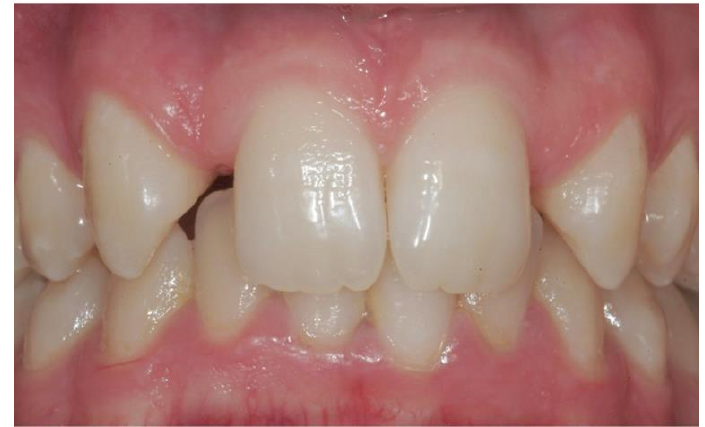
Figure 5. Bilateral agenesis of the maxillary lateral incisors.